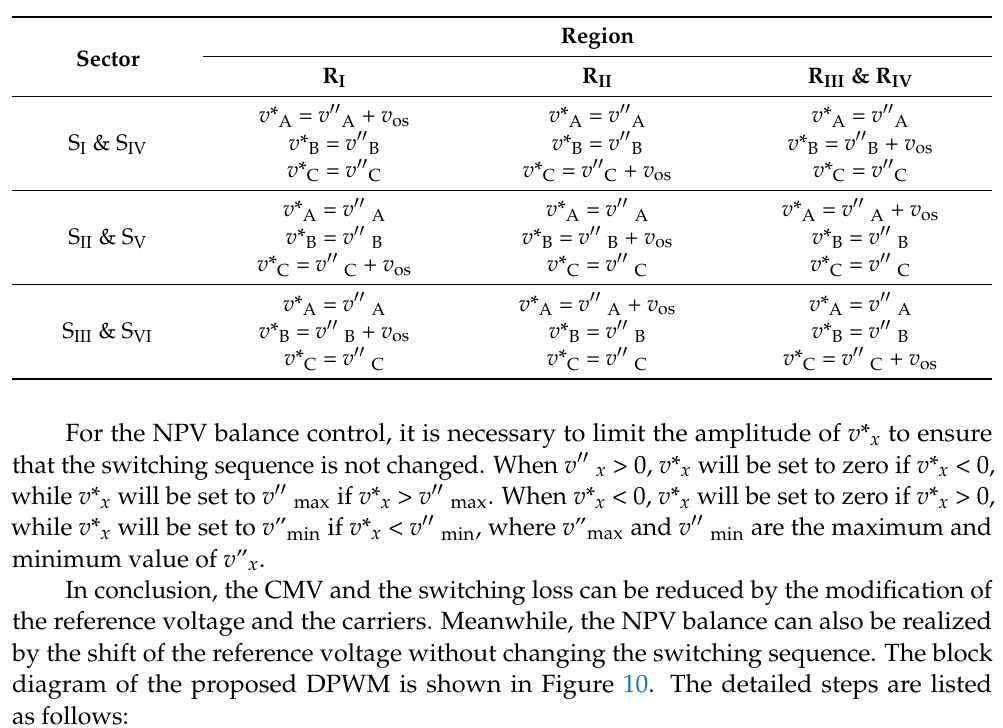
Figure 11. The prototype of OPAL-RT ® OP5700 driven three-level inverter.